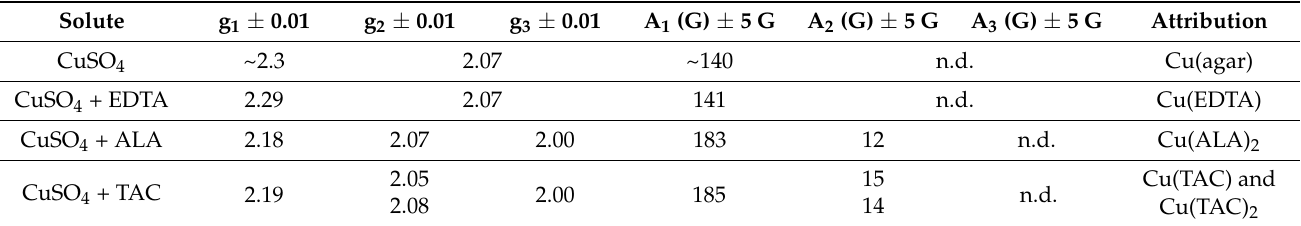
Table 2. Parameters and attribution of electron paramagnetic resonance (EPR) signals observed at 123 K in agar gels.